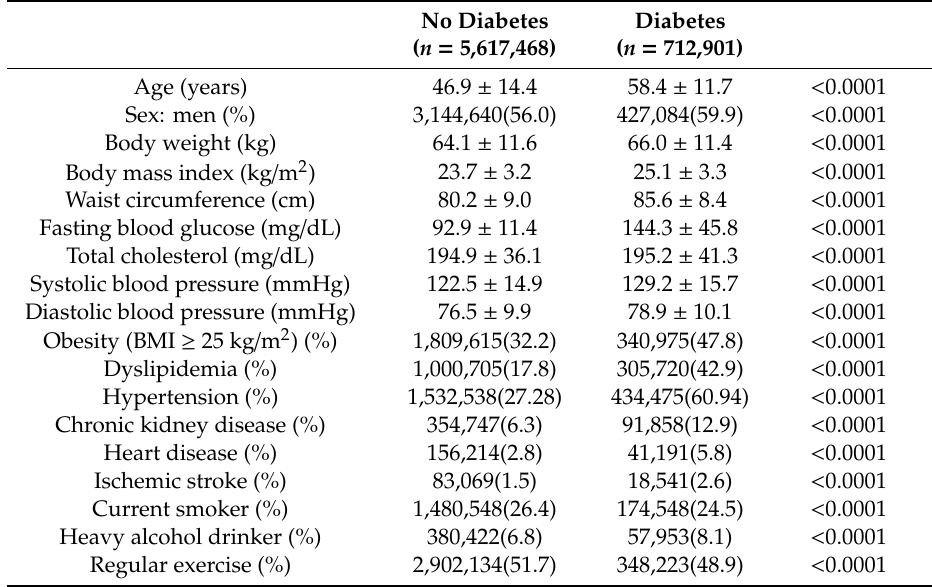
Table 1. General characteristics of the participants according to baseline diabetes status. No